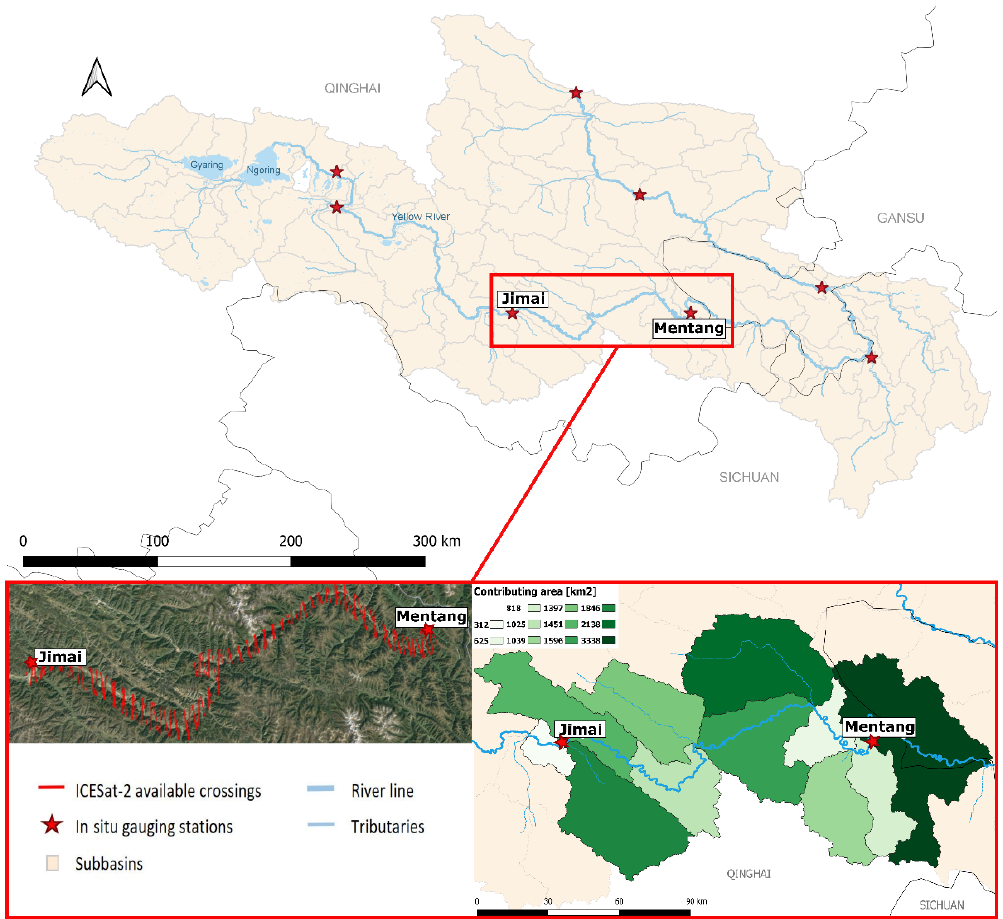
Figure 1. Area of interest and in situ gauging stations in the upstream area of the Yellow River. Calibration is performed for the river reach between Jimai and Mentang (red box and magnified inset). The bottom right image represents the catchment area along the river reach. The bottom left image shows the ICESat-2 crossings available in the river